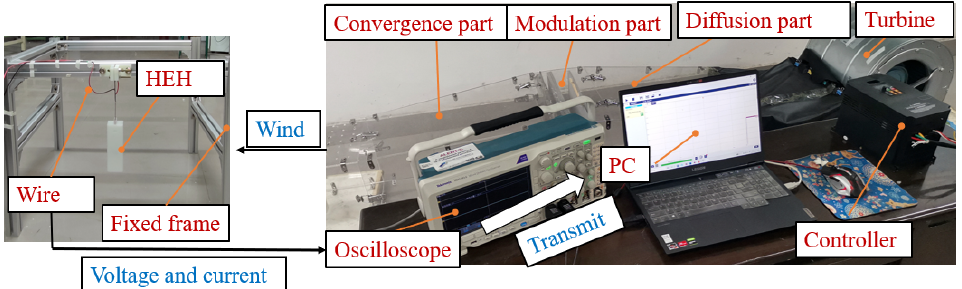
Figure 11. Schematic diagram of experiment equipment.